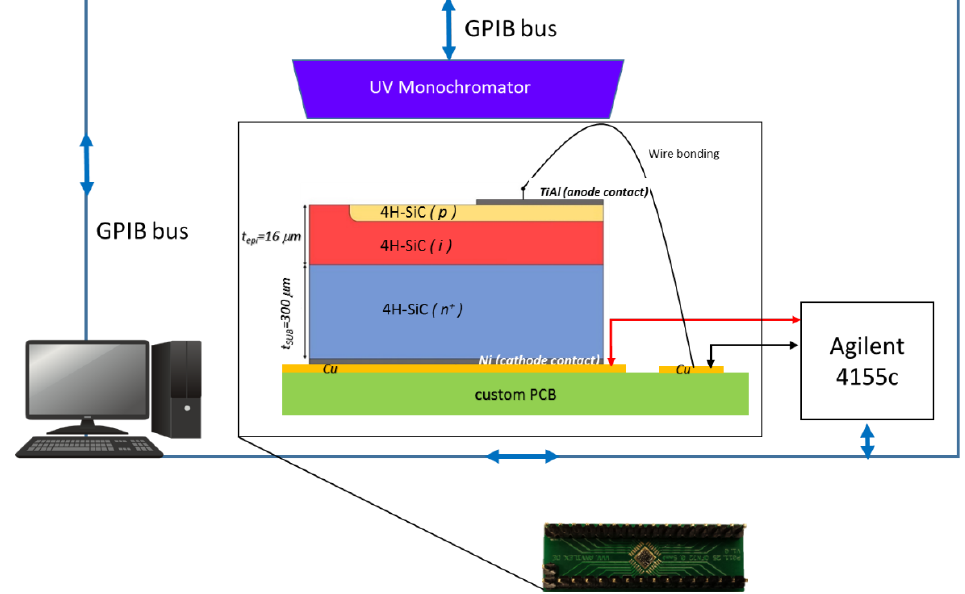
Figure 5. Schematic experimental setup and fabricated microchip bonded on a custom PCB for a stable remotely controlled measurement.